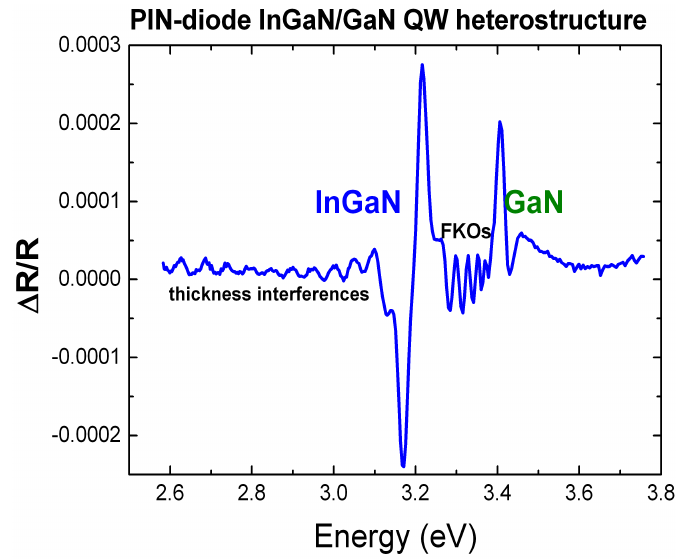
Figure 7. ER spectrum of PIN-diode based on In 0.055 Ga 0.945 N/GaN double heterostructure quantum-well with thickness interferences at energies below the band gap energy of In 0.055 Ga 0.945 N.